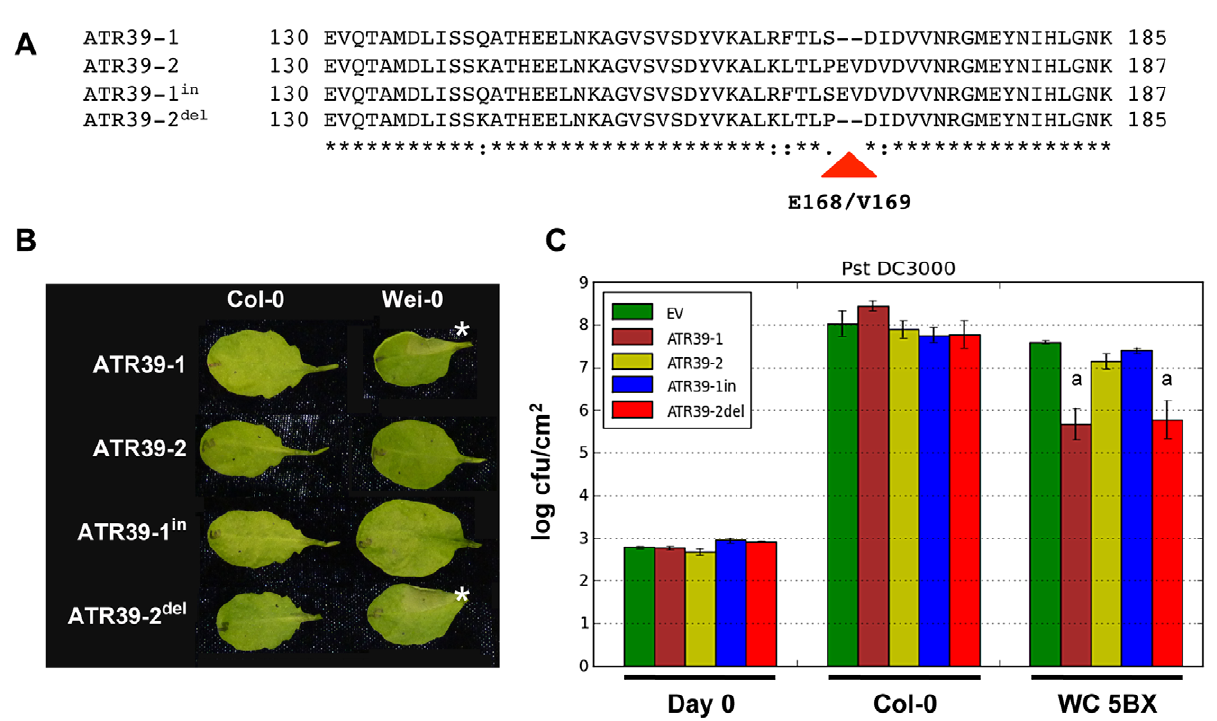
Figure 4. Amino acids E168/V169 abolish recognition of ATR39. A) Alignment of the C-terminal regions of ATR39 alleles and their corresponding insertion/deletion constructs. E168/V169 are indicated by a triangle. B) Only alleles lacking E168/V169 trigger an HR when delivered by Pf 0. The lower half of each leaf was inoculated with an empty vector control. Pictures were taken 24 hpi. Stars highlight positive HR. C) Pst DC3000 growth assay with indicated ATR39 insertion/deletion alleles. Significant differences as determined by Student’s t-test are indicated by small letters (P , 0.005). Experiments were repeated at least twice with similar results.